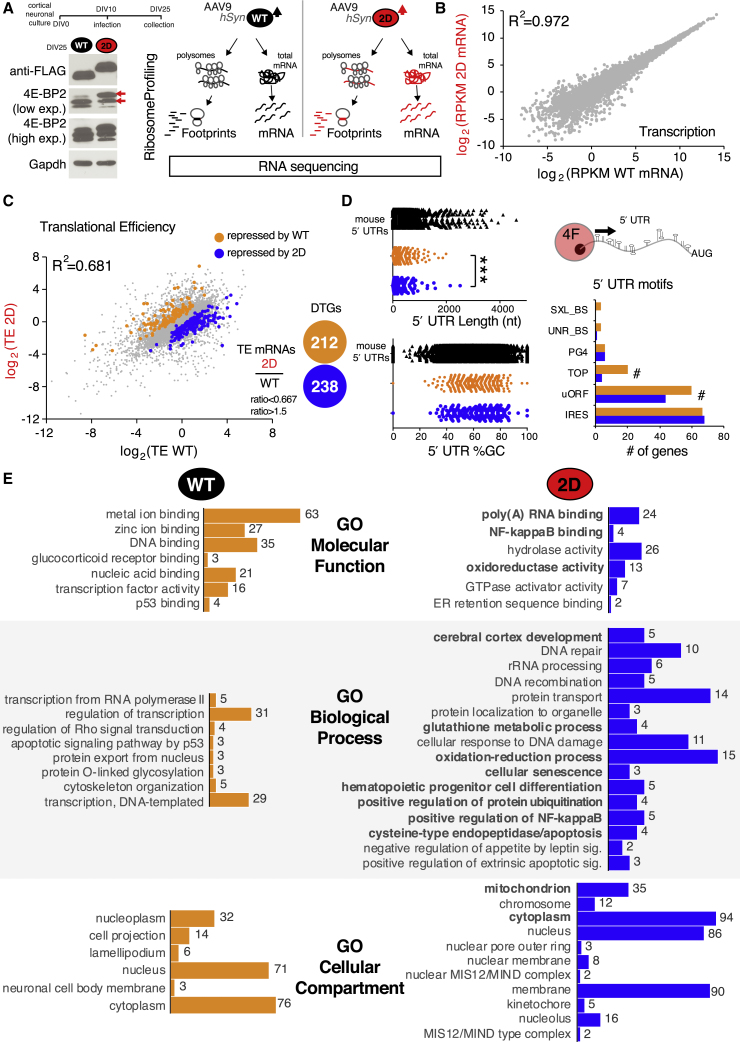
Overexpression of Deamidated 4E-BP2 Alters the Neuronal Translational Landscape(A) Left: overexpression of FLAG-tagged 4E-BP2 (WT or 2D) using AAV9. Representative immunoblots from DIV25 mouse cortical neuron lysates, infected at DIV10. GAPDH is a loading control. Right: diagrammatic depiction of the ribosome profiling experiment.(B) Scatterplot and correlation of RPKM measured from WT or 2D mRNA from DIV25 neurons, as a proxy for transcription, from DIV25 overexpressing neurons.(C) Scatterplot and correlation of translational efficiency (footprint RPKM normalized to mRNA RPKM) between WT and 2D overexpressing DIV25 neurons (log2 RPKM of 2D versus WT). Differentially translated genes (DTGs), repressed by WT (orange) or 2D (blue), are shown for 0.667 < ratio > 1.5.(D) 5′ UTR analysis of DTGs versus mouse 5′ UTR collection: length (nt), %GC content, and UTRdb motifs. Data are shown as means ± SEMs. For length and %GC: one-way ANOVA; Bonferroni’s post hoc; ∗∗∗p < 0.001; # change in motif abundance.(E) DAVID analysis of DTGs (WT left, orange; 2D right, blue) for Gene Ontology (GO) categories molecular function, biological processes, and CC. The number of genes in each category is shown and the order of categories is by decreasing p value (see Table S3; all p values shown here are <0.05). The categories in bold are discussed further in the text.See also Figure S6 and Tables S3 and S4.